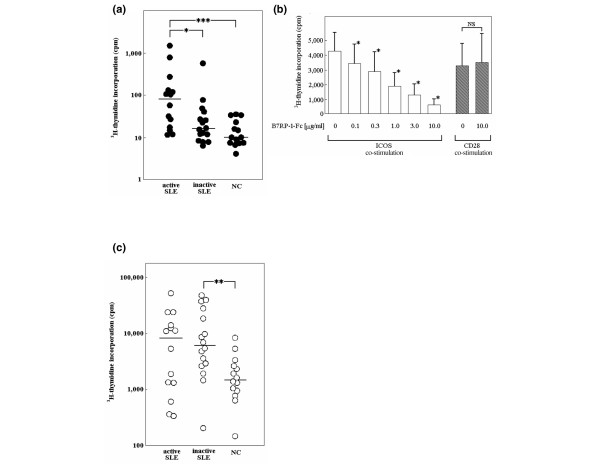
Proliferative response of peripheral blood T cells to ICOS co-stimulation. Peripheral blood T cells isolated from patients with active SLE (n = 14), patients with inactive SLE (n = 16), and normal control individuals (n = 14) were cultured for 72 hours with or without stimulation and pulsed with [3H]thymidine during the last 8 hours. (a) [3H]thymidine incorporation without stimulation. The median value of each group was as follows: active SLE, 78.9 counts/min; inactive SLE, 15.9 counts/min; and normal control individuals, 9.9 counts/min. (b) Inhibition of ICOS co-stimulation by B7RP-1. Peripheral blood T cells from normal control individuals were stimulated with either anti-CD3 mAb plus JTA009 or anti-CD3 mAb plus anti-CD28 mAb in the presence of various concentration of B7RP-1-Fc. Proliferation of peripheral blood T cells with ICOS co-stimulation, but not that with CD28 co-stimulation, was dose dependently inhibited by the addition of B7RP-1-Fc to cell culture medium. (c) [3H]thymidine incorporation with ICOS co-stimulation. The median values in each group for ICOS co-stimulation were as follows: active SLE, 8063 counts/min; inactive SLE, 6050 counts/min; and normal control individuals, 1481 counts/min. Bars indicate median values in each group. *P < 0.05, **P < 0.01, ***P < 0.005 by Mann-Whitney U-test. B7RP, B7-related protein; ICOS, inducible co-stimulator; mAb, monoclonal antibody; NC, normal control; SLE, systemic lupus erythematosus.